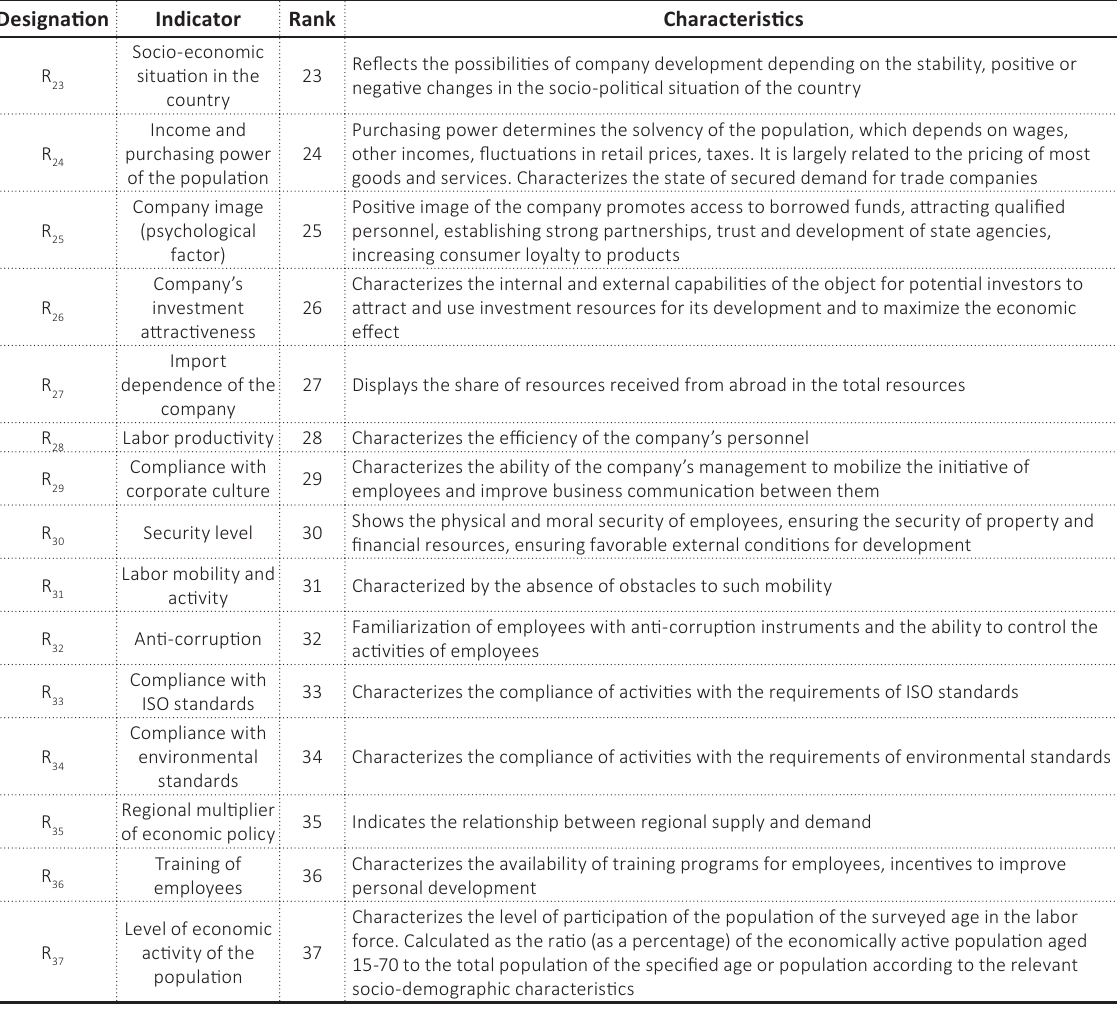
Table 2 (cont.). Indicators for assessing the stability of production and trading